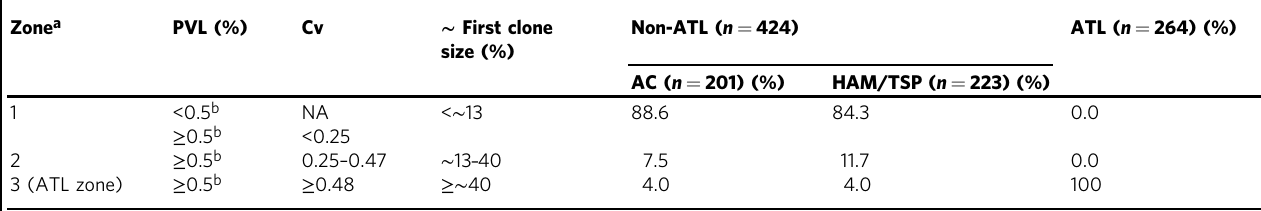
Table. 1 Classi fi cation of a potential Adult T-cell leukemia/lymphoma (ATL) risk based on clonality value of HTLV-1- infected cells.